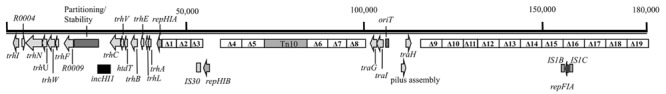
R27 physical map. The 19 deletions attempted are shown (Δ1–Δ19).